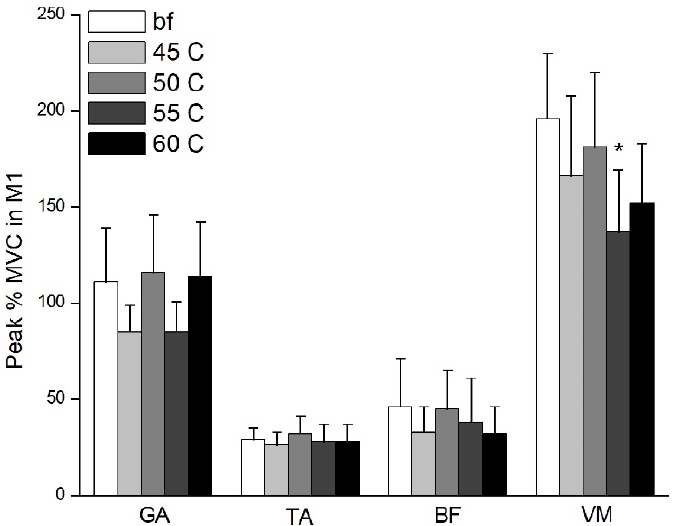
Figure 4. Peak %MVC of lower extremity in M1 stage. bf = barefoot. * Indicates significant difference with barefoot ( p < 0.01).